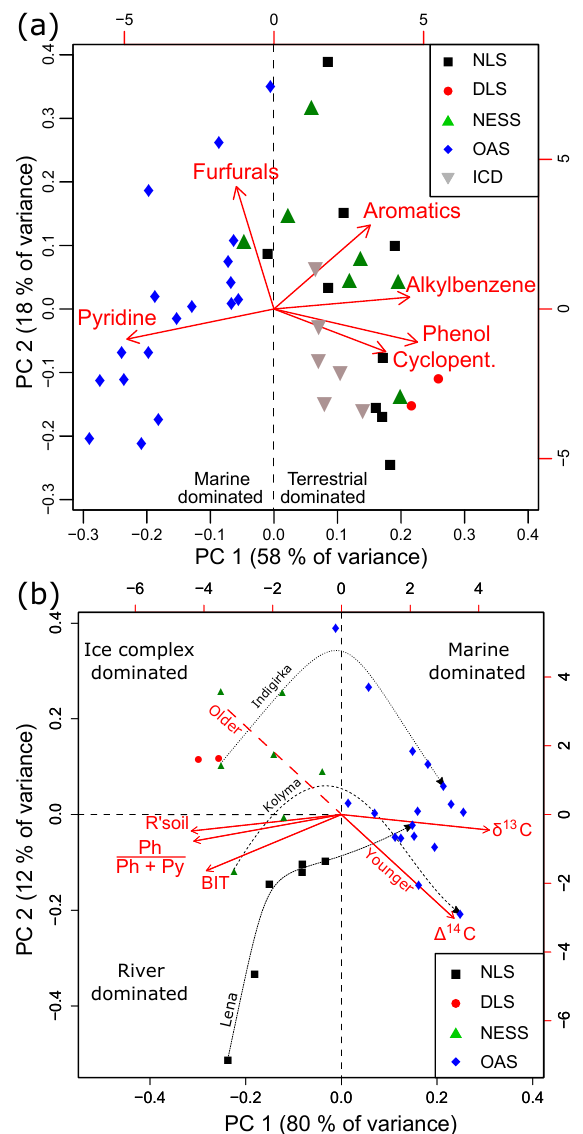
Figure 6. Principal component analyses of (a) various measured compounds from py-GCMS analysis (see Fig. 2 and Table S2) and (b) various terrestrial–marine proxies. Sample location regions are represented by symbol shapes and colours (see legend). Inferred do- mains of marine and terrestrial (split into river and ICD sections in panel b ) dominance are shown with straight dashed lines. Off- shore transects of surface sediments from major rivers to the ESAS (panel b ) are shown using curved dotted lines and labelled with the river name at the nearshore end of the offshore transect. (DLS: Dmitry Laptev Strait; NLS: nearshore Laptev Sea; NESS: nearshore East Siberian Sea; OAS: offshore Arctic